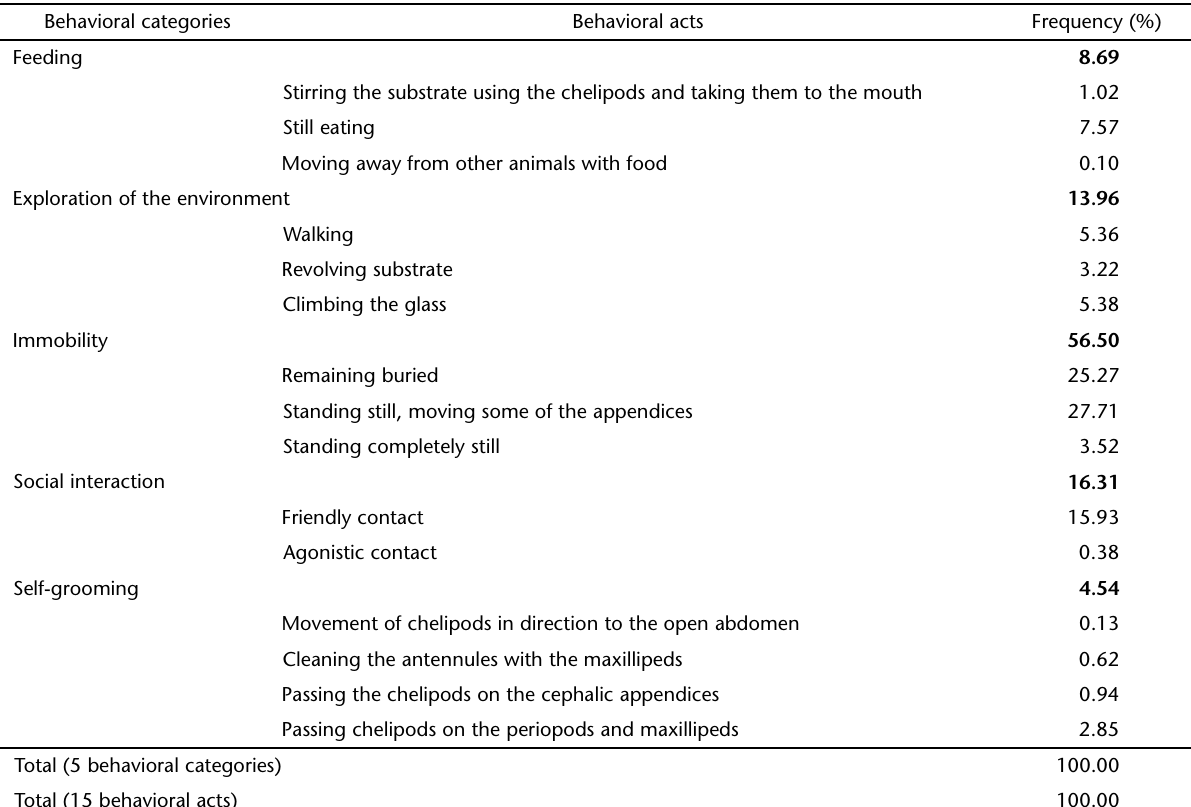
Table II. Trichodactylus panoplus : average frequency of the behaviors observed in the three replicates of experiments. Behavioral